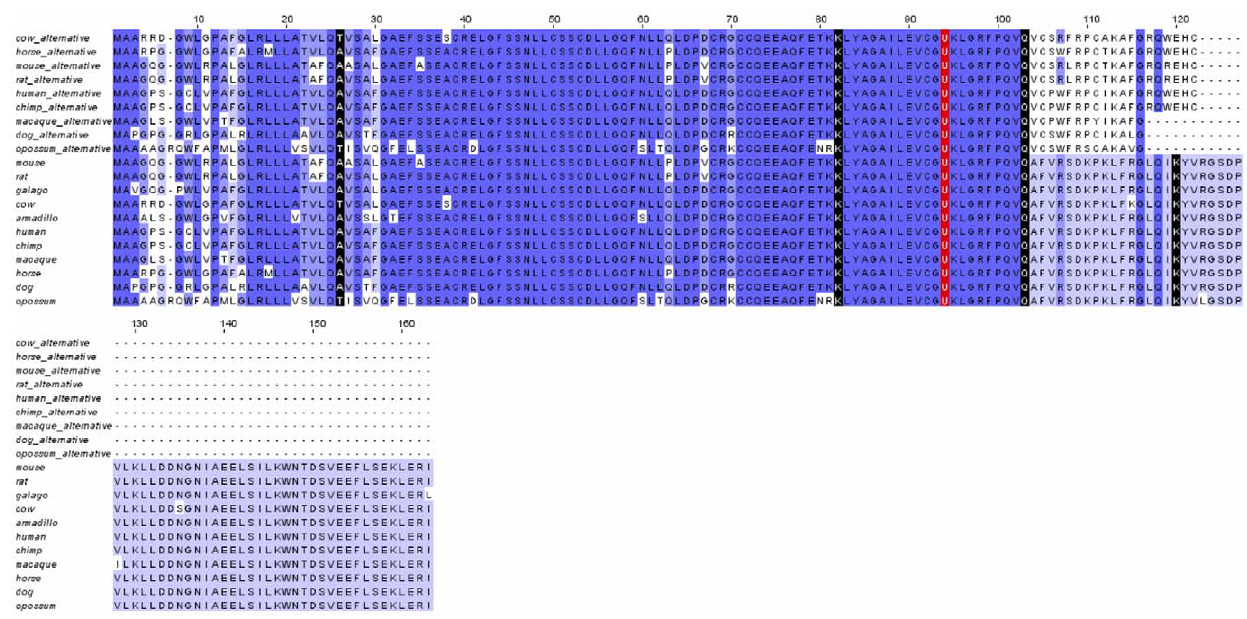
Figure 8. Multiple sequence alignment of Sep15 and a Sep15 alternative isoform. The last residue of each exon is marked in black and Sec in red. For human and mouse, ESTs support the presence of the isoform. For the other species shown, the protein sequences were predicted simulating skipping the 4th exon.